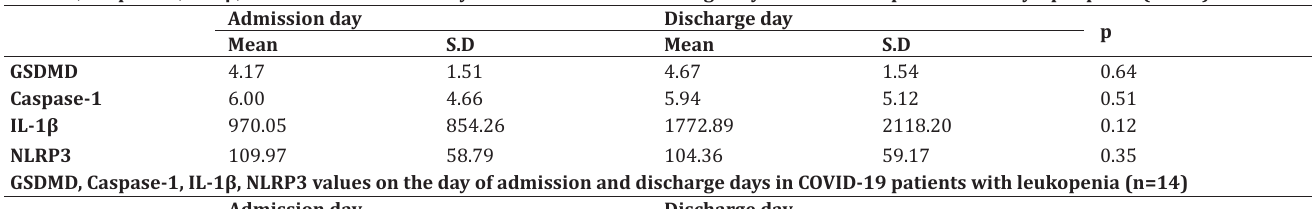
GSDMD, Caspase-1, IL-1 β , NLRP3 values on the day of admission and discharge days in COVID-19 patients with lymphopenia,leukopenia and neutropenia GSDMD, Caspase-1, IL-1β, NLRP3 values on the day of admission and discharge days in COVID-19 patients with lymphopenia (n =28)